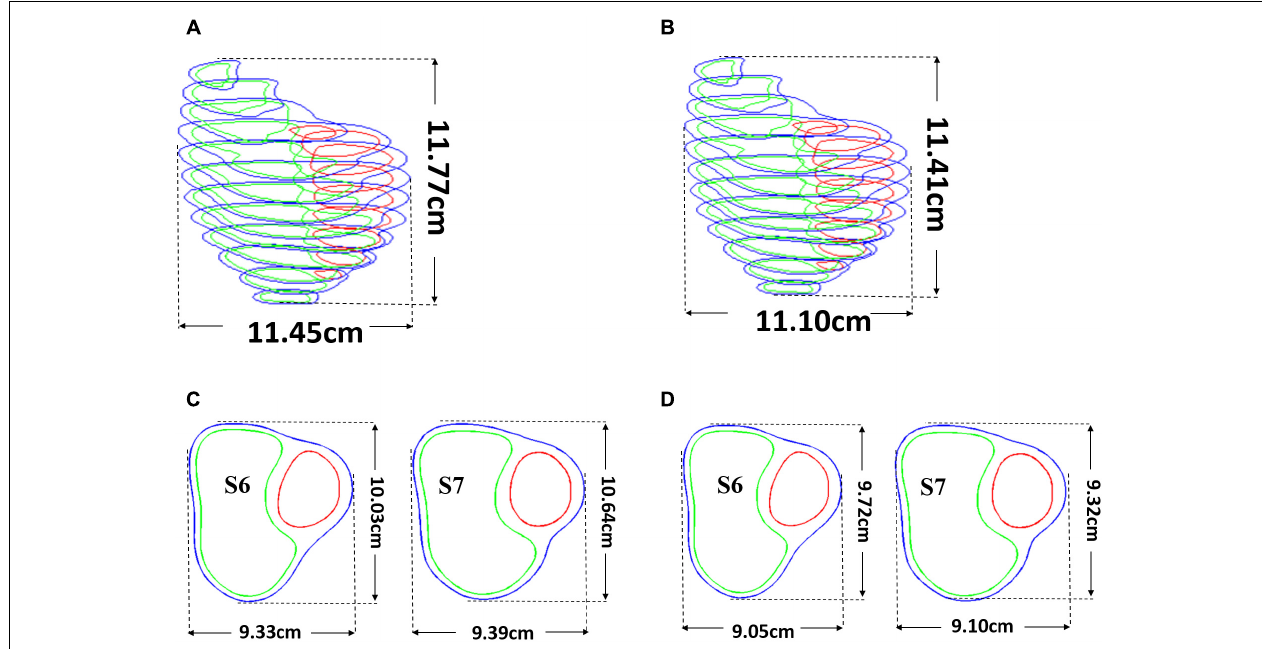
FIGURE 4 | Pre-shrink process. (A) Stacked contours before pre-shrink. (B) Stacked contours after preshrink with a long-axis shrinking rate (3%). (C) Slices 6 and 7 before preshrink. (D) Slices 6 and 7 after preshrink, the shrink ratio for inner contours was 2–3%. The outer contours shrink ratio was determined to meet the conservation of mass of the total ventricular wall.